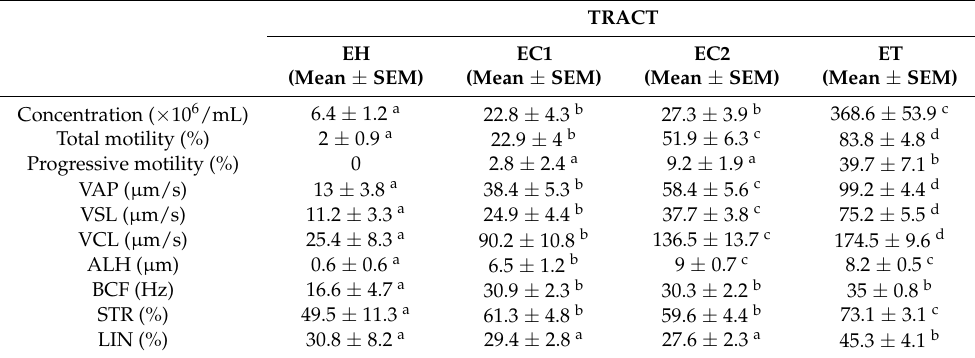
Table 2. Sperm count and kinetic (mean ± standard error of the mean—SEM) in the different epididymal tracts of the